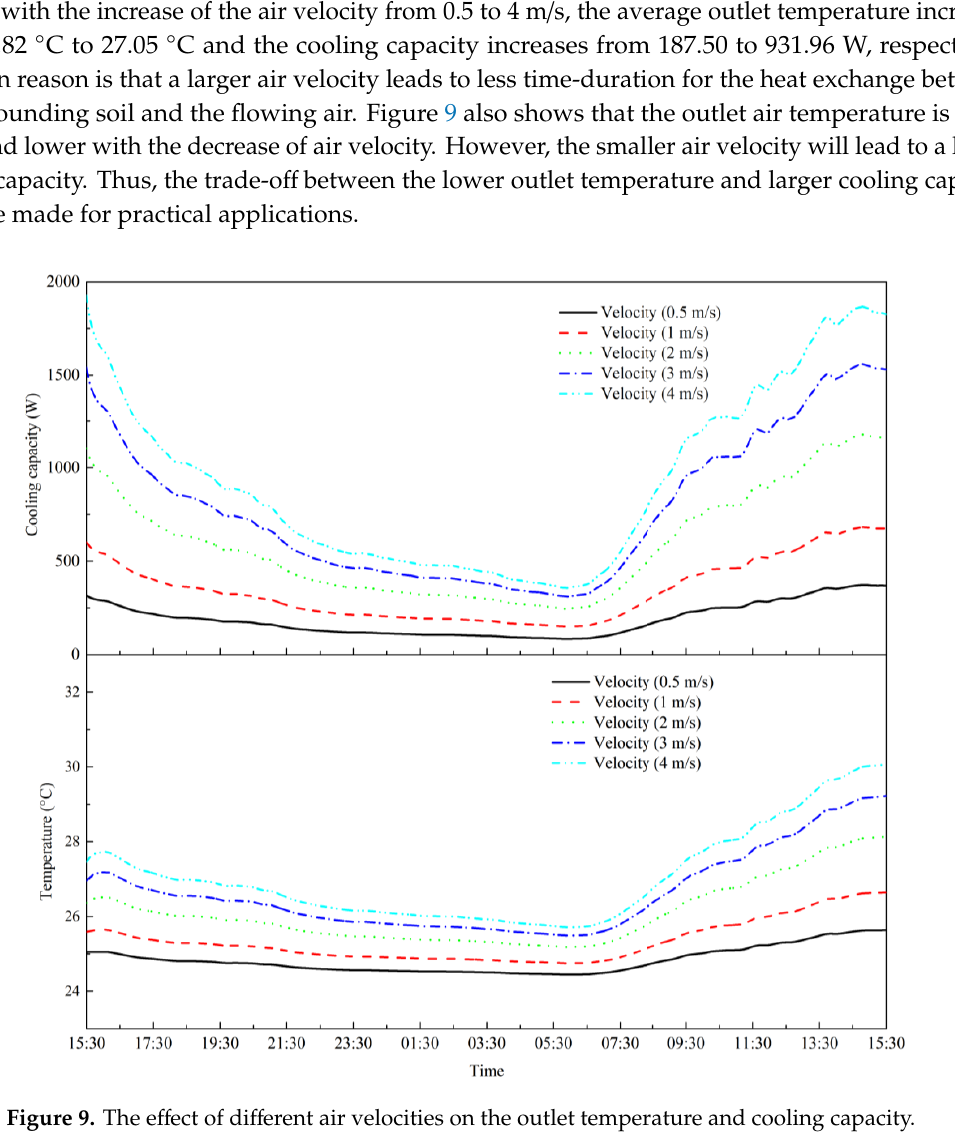
Figure 9. The effect of different air velocities on the outlet temperature and cooling capacity.. Table 5. The average outlet temperatures and cooling